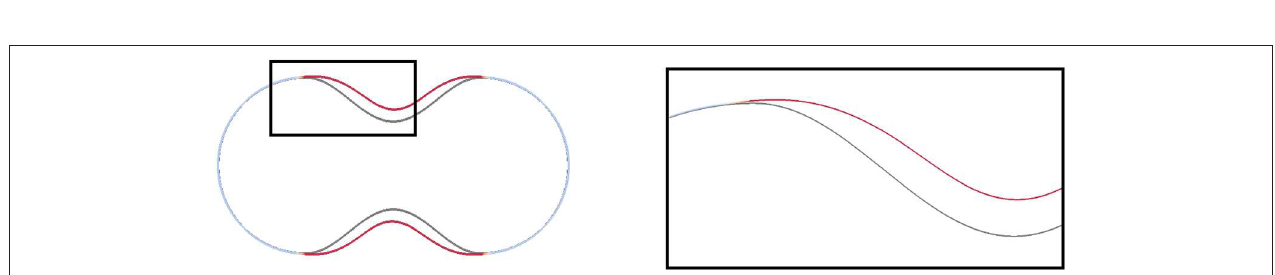
FIGURE 4 | Slices through the central axis of shapes obtained in simulations that we report on in section 5.3. A magnified image of the black box is presented on the right. The initial (dark gray) and the final shape (red/light blue) for the computation with the data from Table 1 are displayed. The color code is as in Figure 3 . Strongly deformed parts of the membrane, where the linkers are broken, are red and predominant in the concave part of the initial shape.